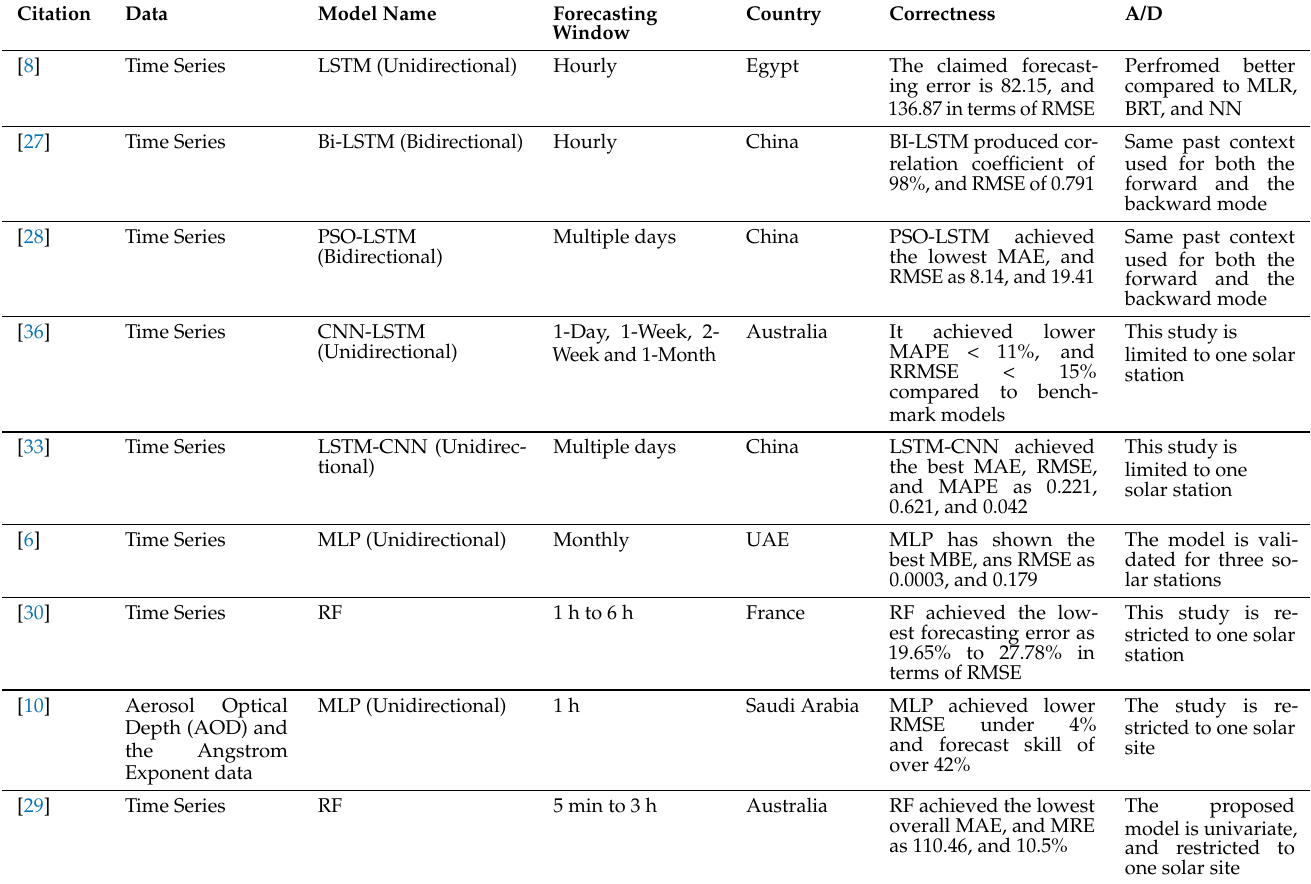
Table 1. Studies based on currently implemented models on solar irradiation